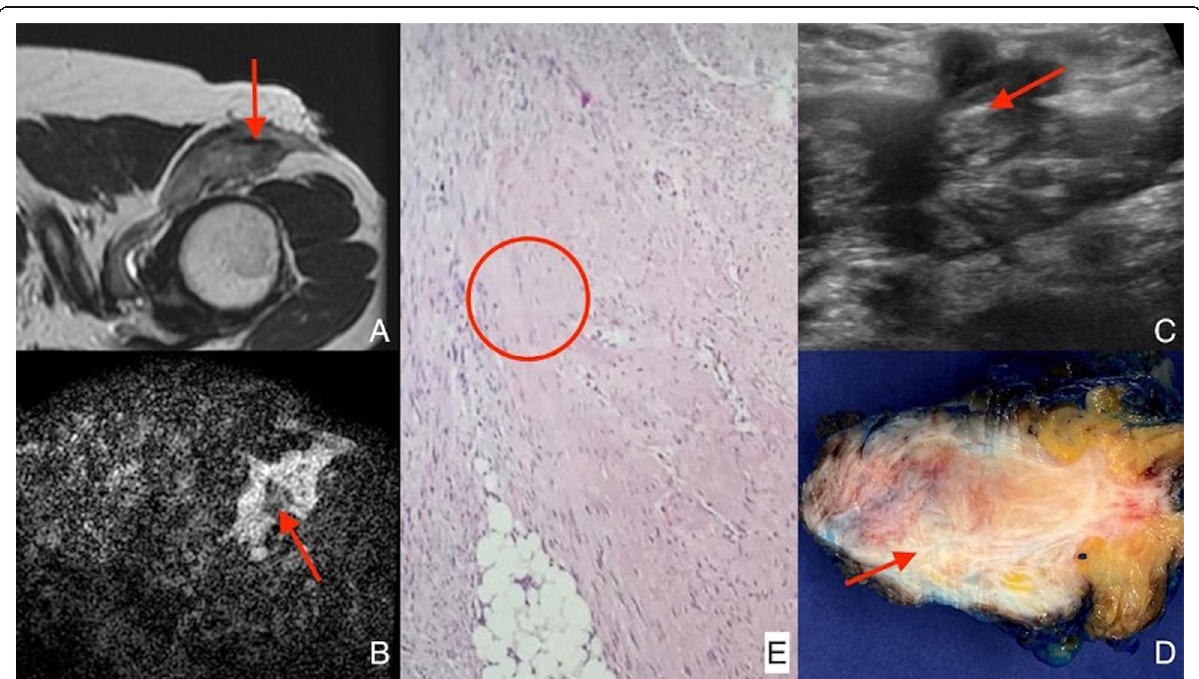
Fig. 4 Radiological-pathological correlation. The hypointense areas in T2 (red arrow in A , axial T2 pre-contrast), poor enhancement in post-contrast